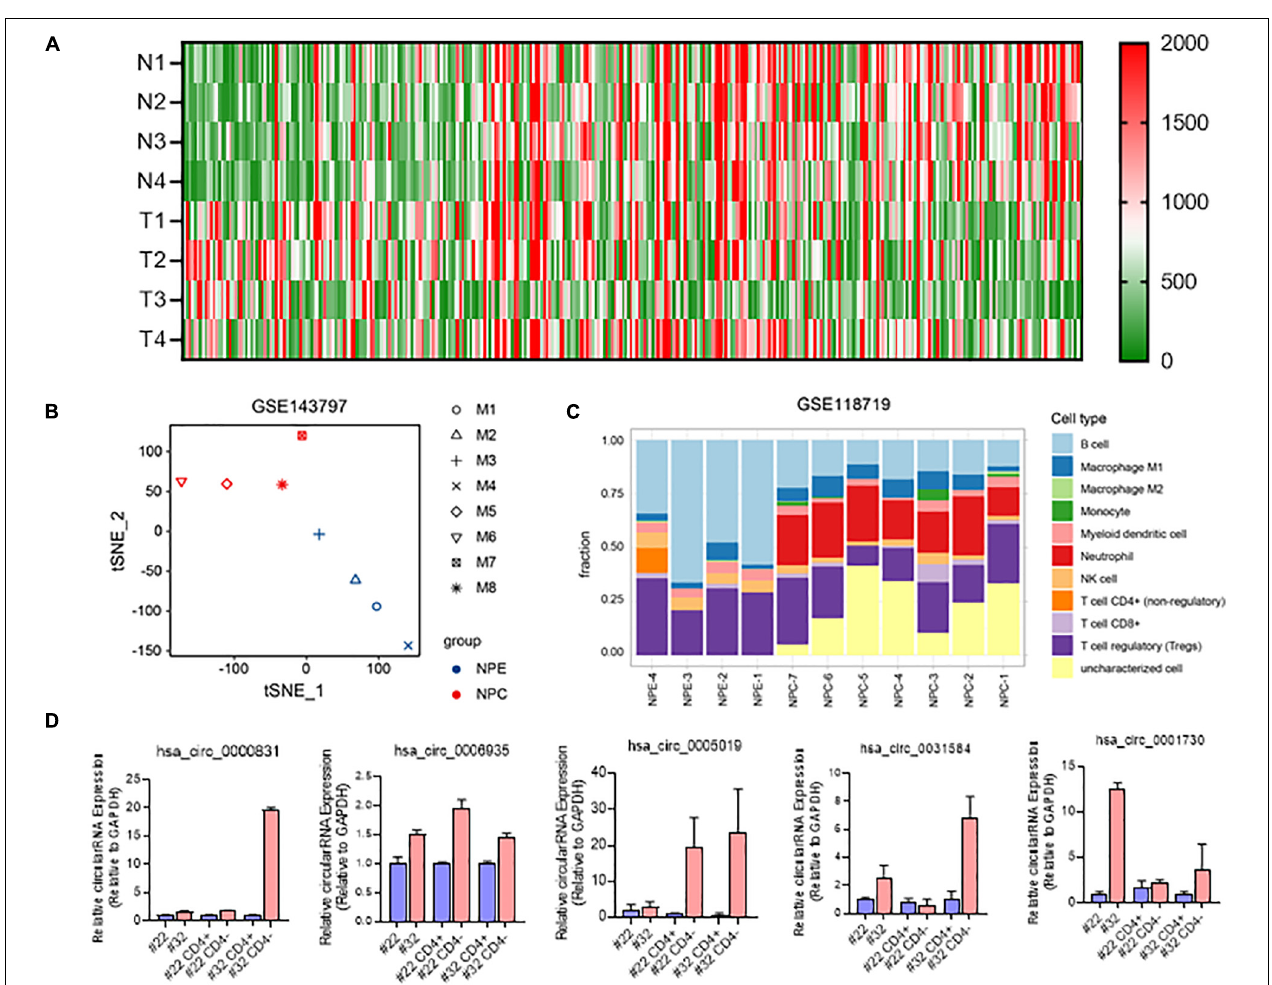
FIGURE 5 | Involvement of circRNAs in NPC immune microenvironment. (A) Heatmap of differently expressed circRNAs in NPC and NPE; (B) t-SNE map of 4 NPE tissues and 4 NPC tissues based on circRNA expression; (C) immunocyte infiltration of 7 NPC tussues and 4 NPE tissues; (D) RNA expression of 5 differently expressed circRNA in NPC tissues and CD3+